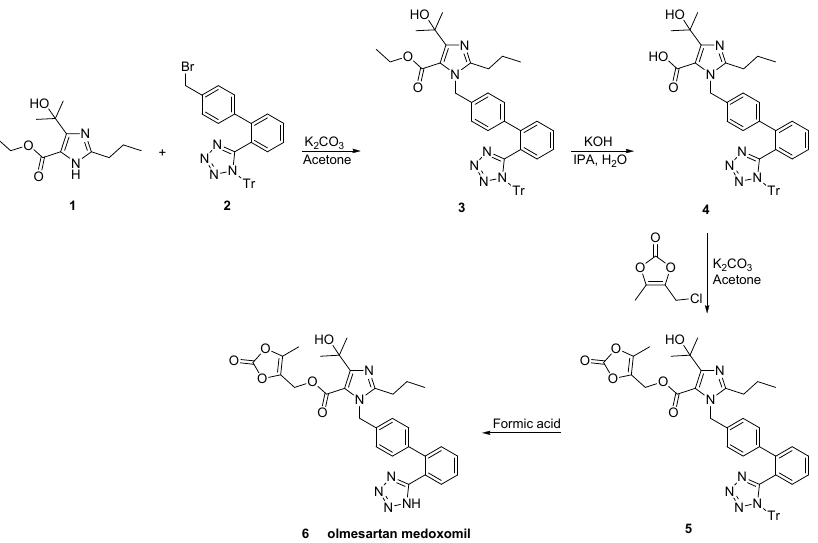
Scheme 23. Synthesis of the prodrug olmesartan medoxomil by Venkanna et al. [52]. In a patent filled by Toplak Casar [53], two variations of an one-pot trityl olmesartan medoxomil synthesis have been described (Schemes 24 and 25). In this methodology, the intermediates are not isolated in each step and by using the same solvent and the same